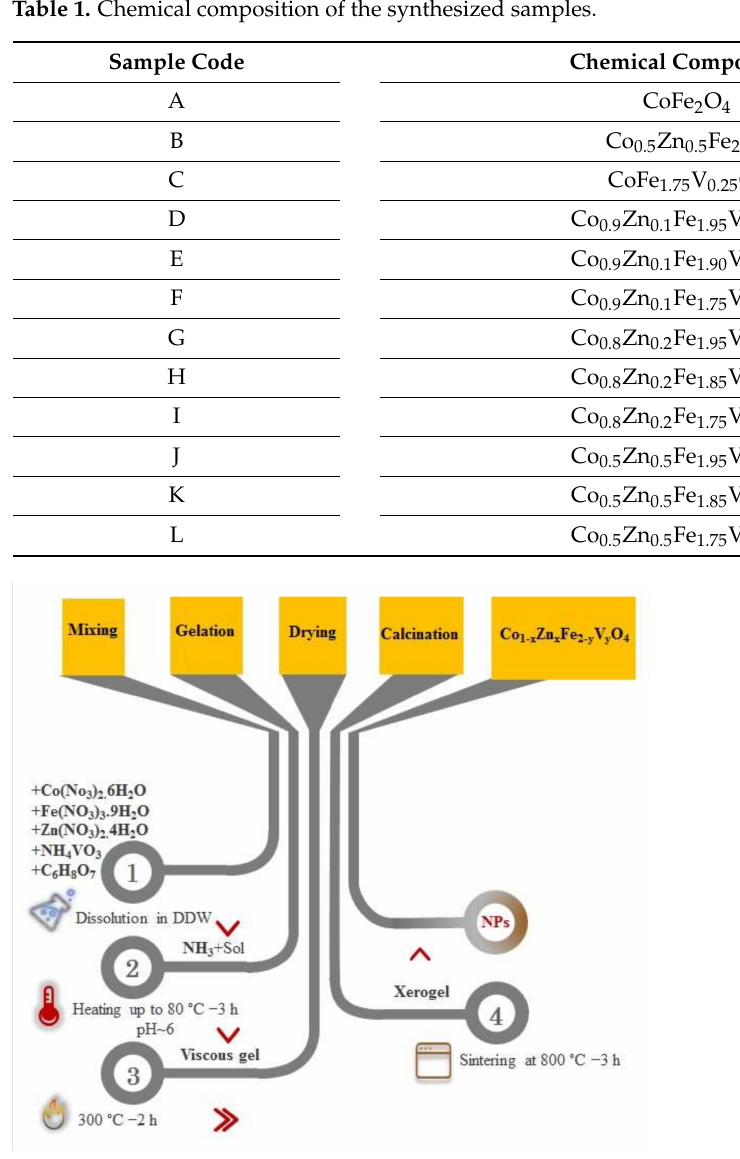
Figure 1. A schematic diagram representing the synthesis process used in the present